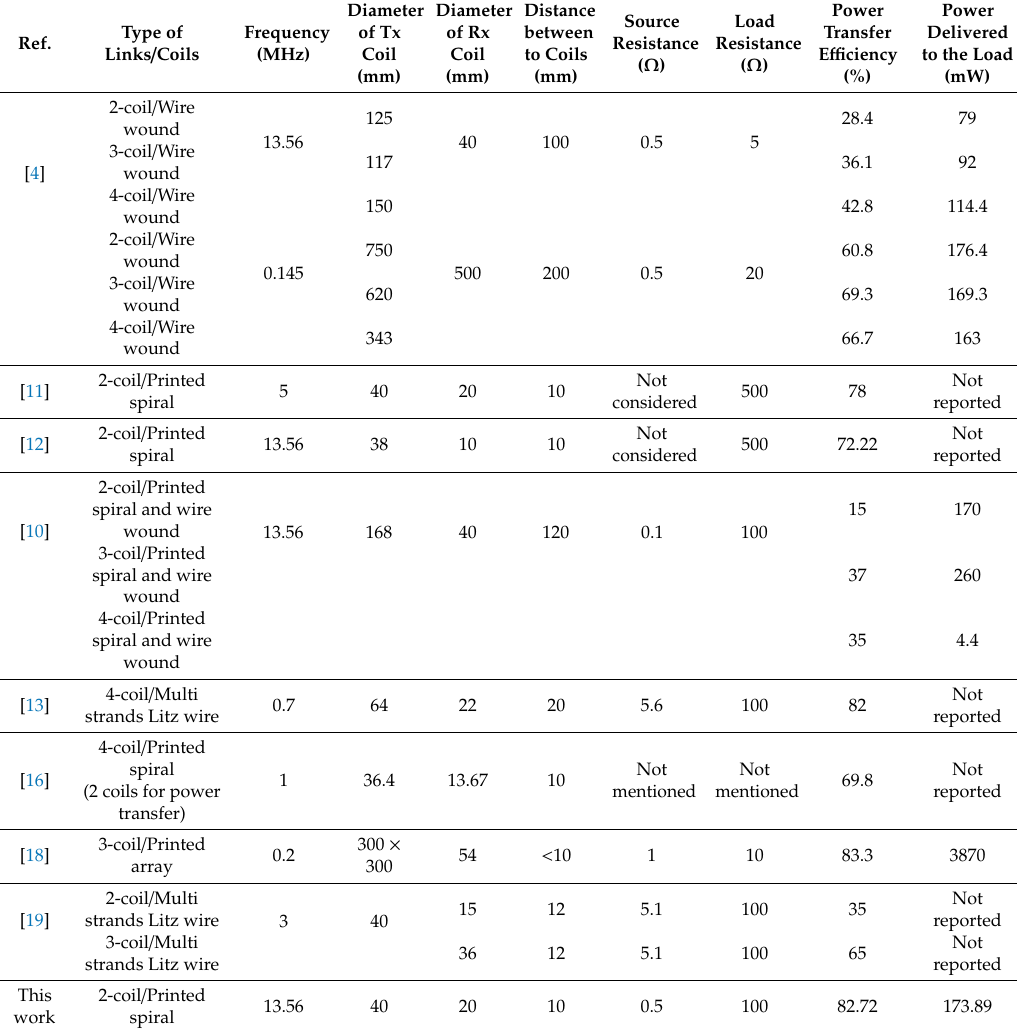
Table 5. Comparison with previously published